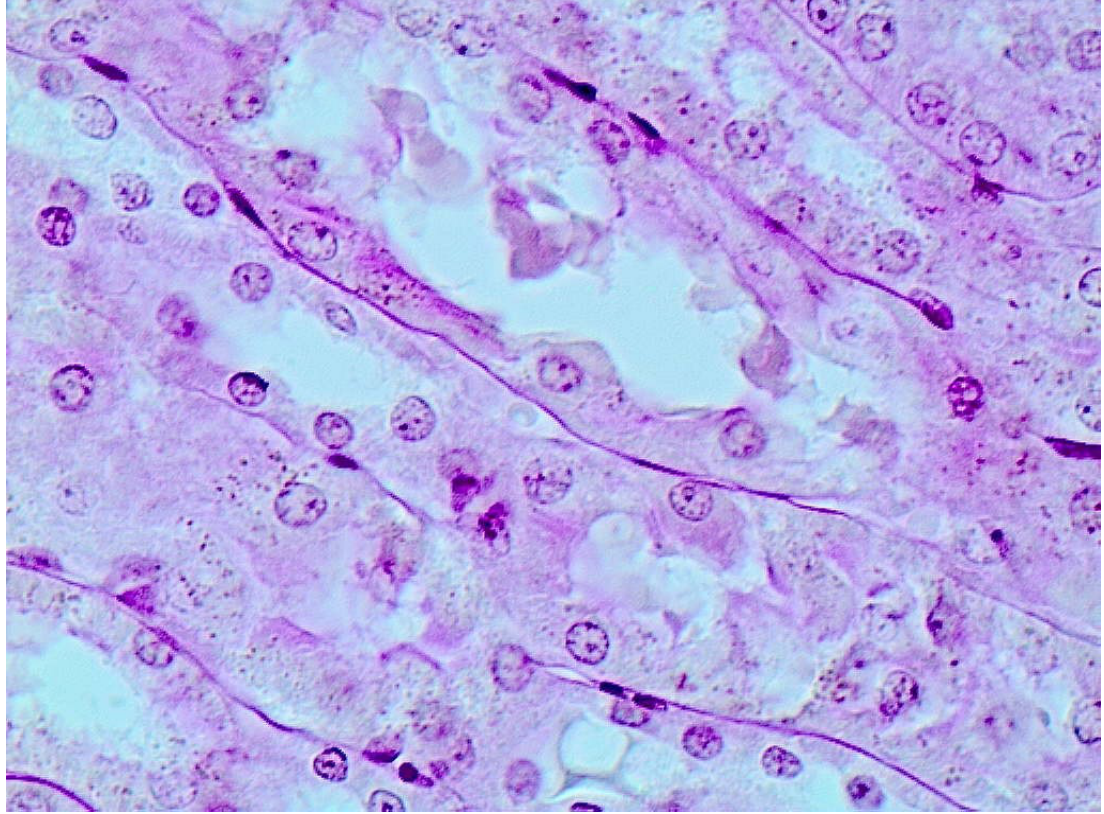
Figure 4. Kidney of a rat exposed to copper oxide nanoparticles. Marked degenerative and necrobiotic changes of tubular epithelial cells; partial destruction of the brush border; small granules of a pigment within сells and tubular lumen. PAS stain, magnification